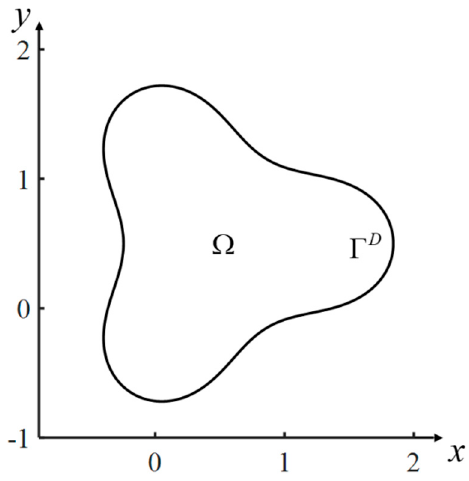
Figure 7. Schematic diagram of the computational domain in case 3. Table 3. Maximum absolute error for case 3.